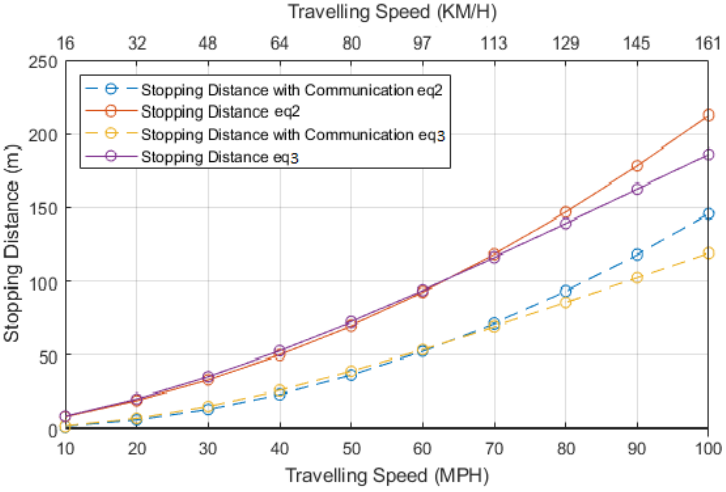
Figure 2. Stopping distance